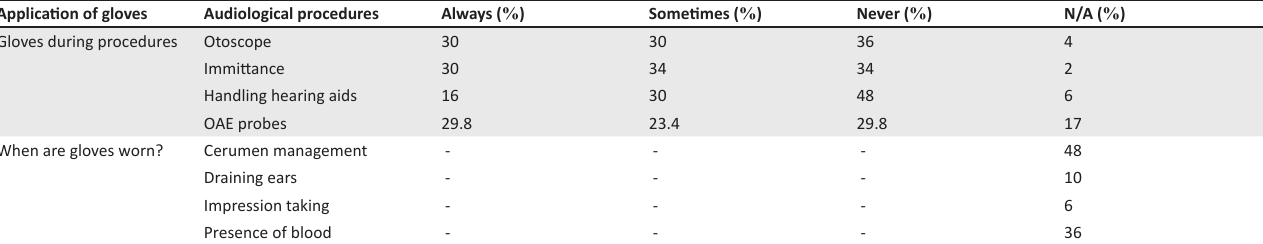
TABLE 3: Application of latex gloves. Application of gloves